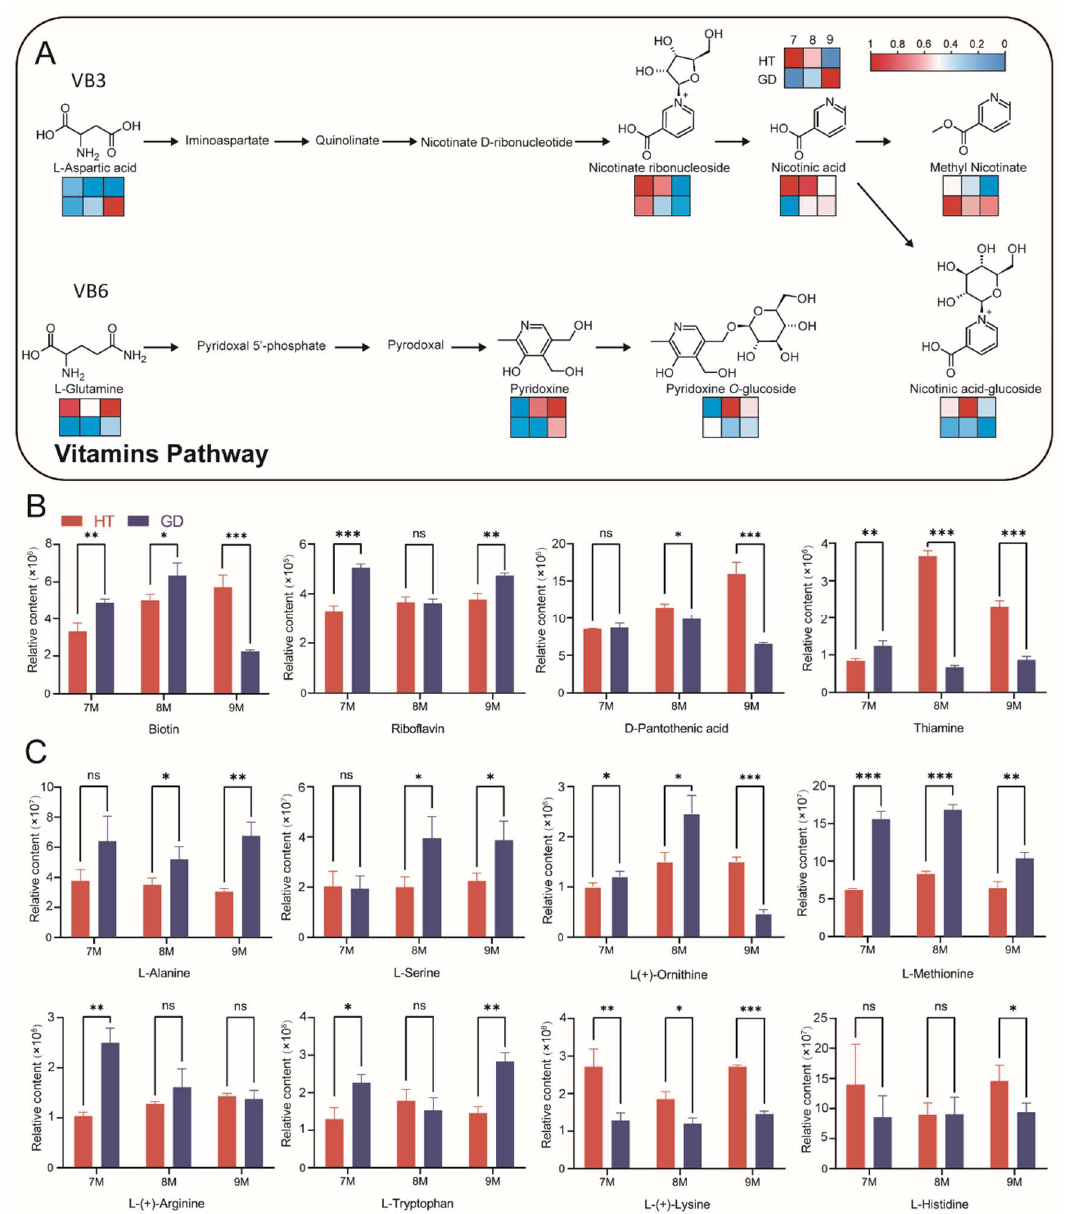
Figure 6. Comparative analysis of nutritional metabolites in the flesh of two coconut varieties across three growth stages. ( A ) Vitamin pathways in coconut flesh. The heatmaps are drawn according to the relative content of metabolites, and the contents of each metabolite were normalized. Columns and rows in the heatmap represent stages and varieties, respectively. In each heatmap, the upper row represents HT, the lower row represents GD. In the columns of each heatmap, 7M, 8M and 9M are represented from left to right. ( B ) Differences in vitamin levels between two coconut varieties across three growth stages. ( C ) Differences in amino acid levels between two coconut varieties across three growth stages. Student’s t test was performed (ns: not significant, * p < 0.05, ** p < 0.01, *** p < 0.001).